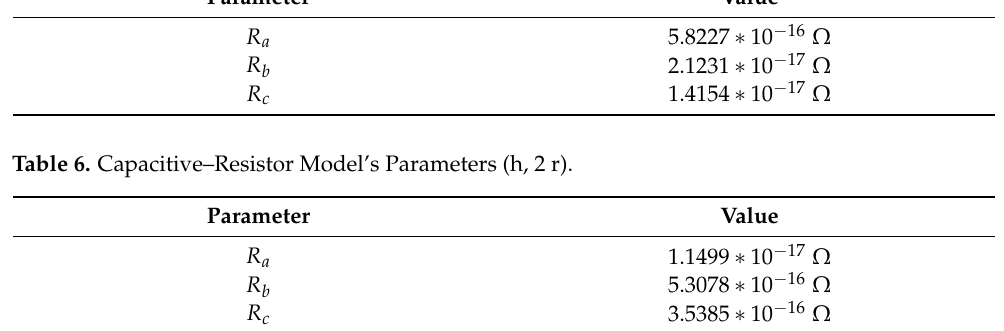
Table 7. Capacitive–Resistor Model’s Parameters (2 h, r).